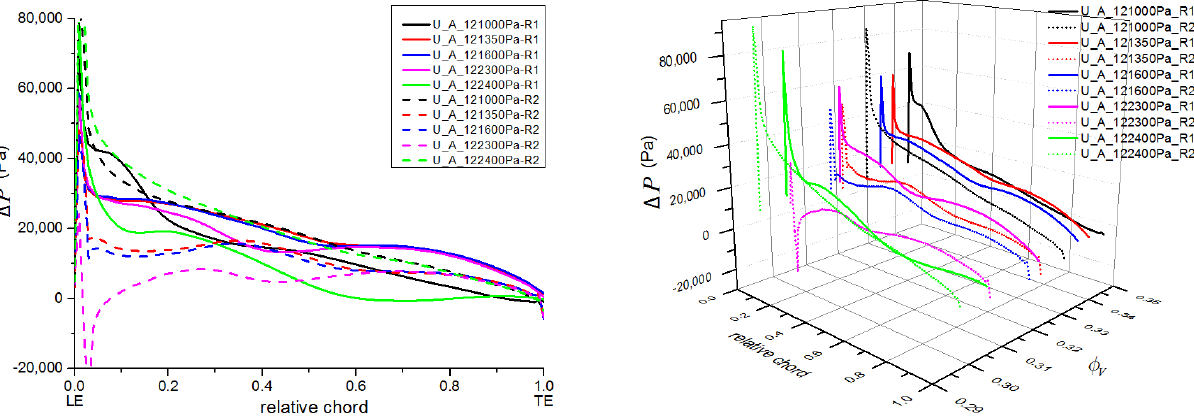
Figure 15. Blade load and corresponding leakage along chord under unsteady conditions. ( a ) Blade load and ( b ) corresponding leakage flow.